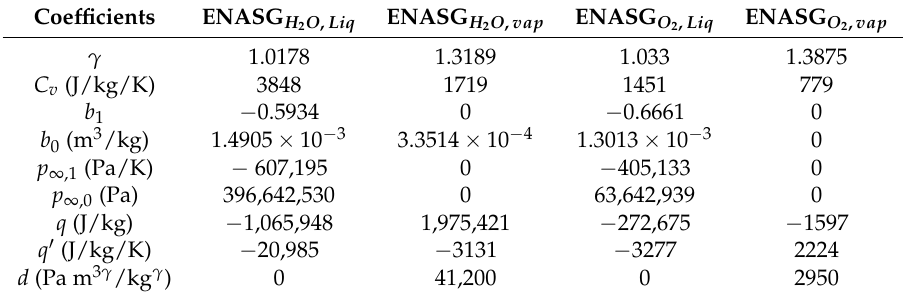
Table A3. Coefficients for water and oxygen for the “alternative” ENASG EOS whose formulation is summarized in Equation (A38). With such description, the gas attractive effects are taken into account via the parameter d but result in conditional convexity, Equation (A39). The liquid ENASG EOS is unchanged, Equation